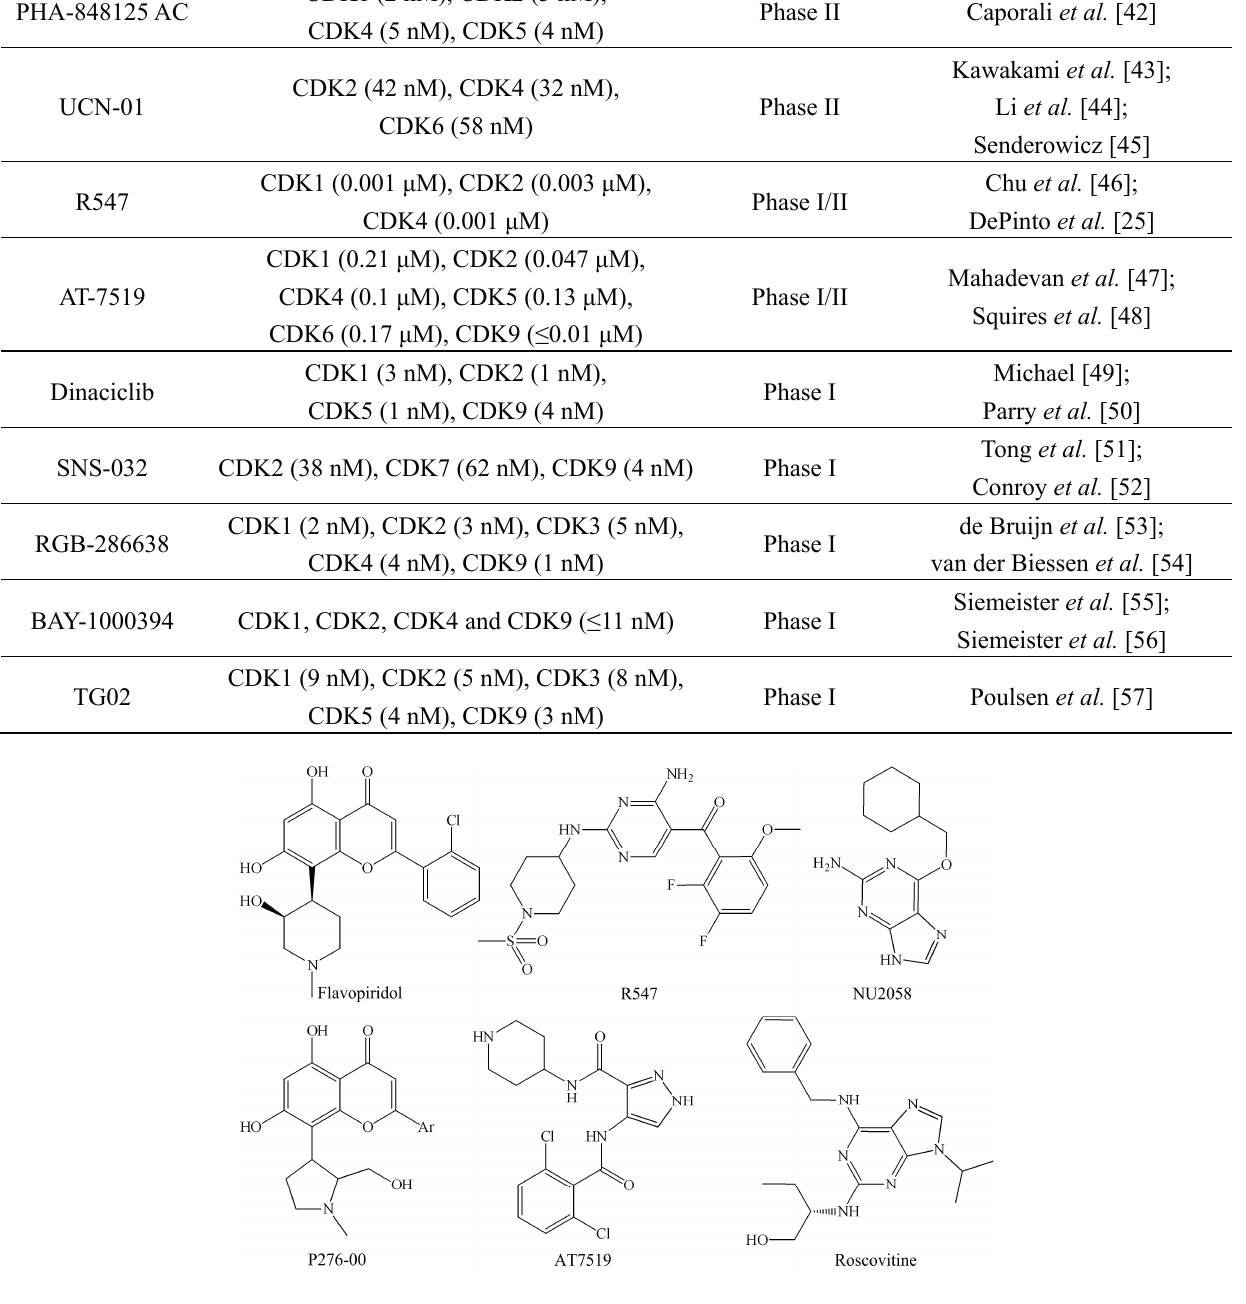
Figure 1. ATP-competitive CDK2